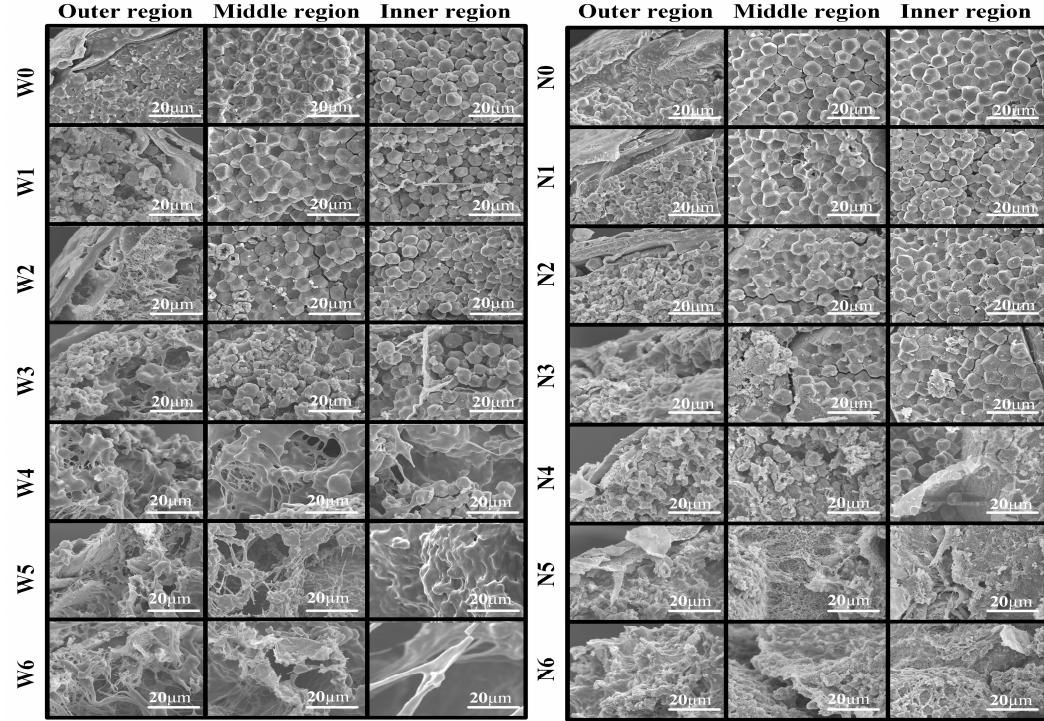
Figure 4. Micrographs of different regions in uncooked and cooked waxy and non-waxy proso millet grains. W0–W6: uncooked, and cooked for 5, 10, 15, 20, 25, and 30 min, respectively; N0–N6: Uncooked and cooked for 5, 10, 15, 20, 25, and 30 min, respectively.